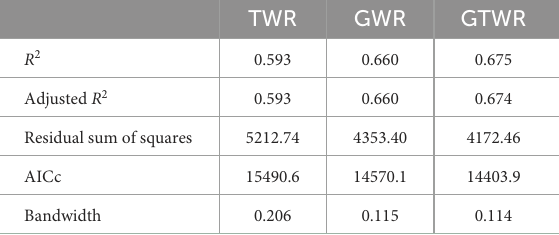
TABLE 3 Comparison of the model test